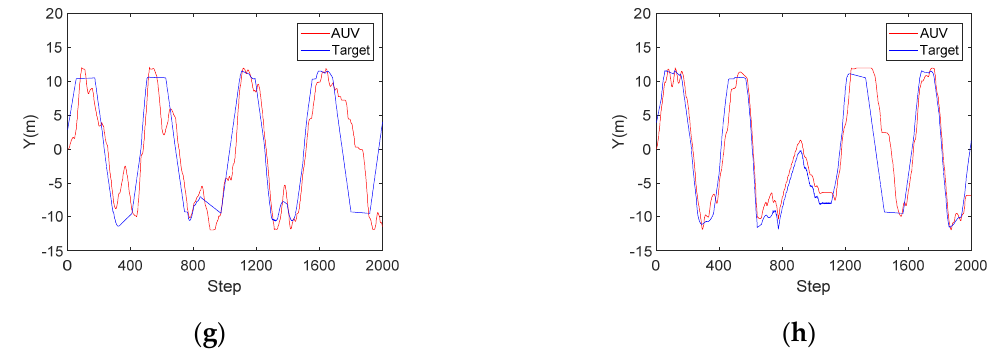
Figure 7. The coordinate change curves in Scene 2 during the process of AUV tracking the target using PPO, SAC, GAIL, and MAG, respectively: ( a – d ) the X-coordinate change; ( e – h ) the Y-coordinate change.